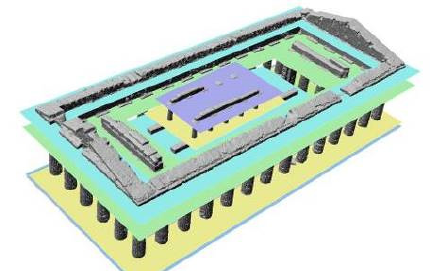
Figure 13. Segmentation with planes in Polyworks of the model of the